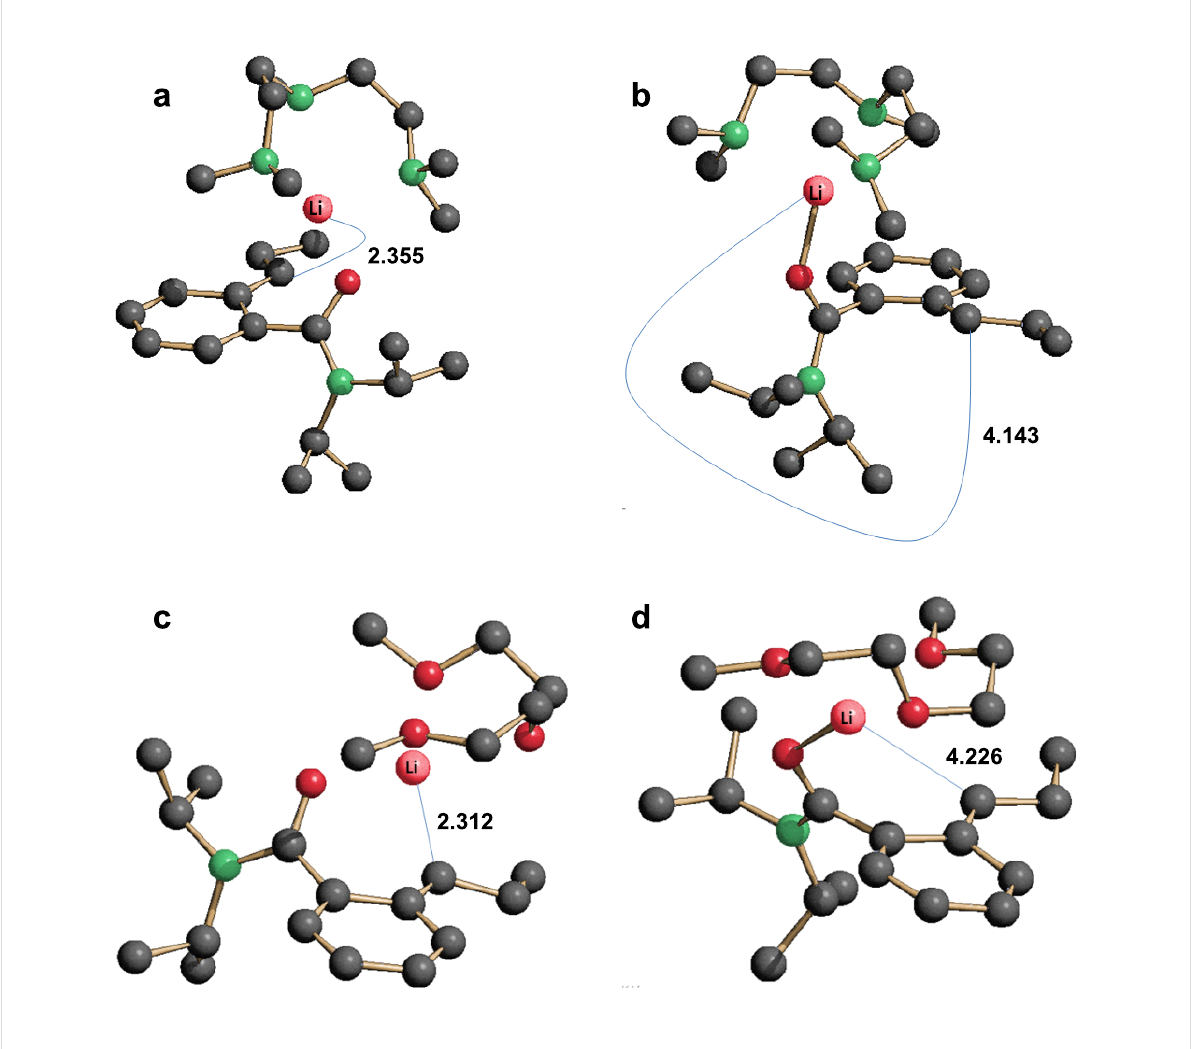
Figure 3: Computed minimum energy conformers (B3LYP density functional/6-311++G(2d,2p) basis set; H-atoms omitted for clarity) of trans - 6 - Li l ·PMDTA with and without a Li–( α -C) interaction (a and b) and trans - 6 -Li l ·DGME with and without a Li–( α -C) interaction (c and